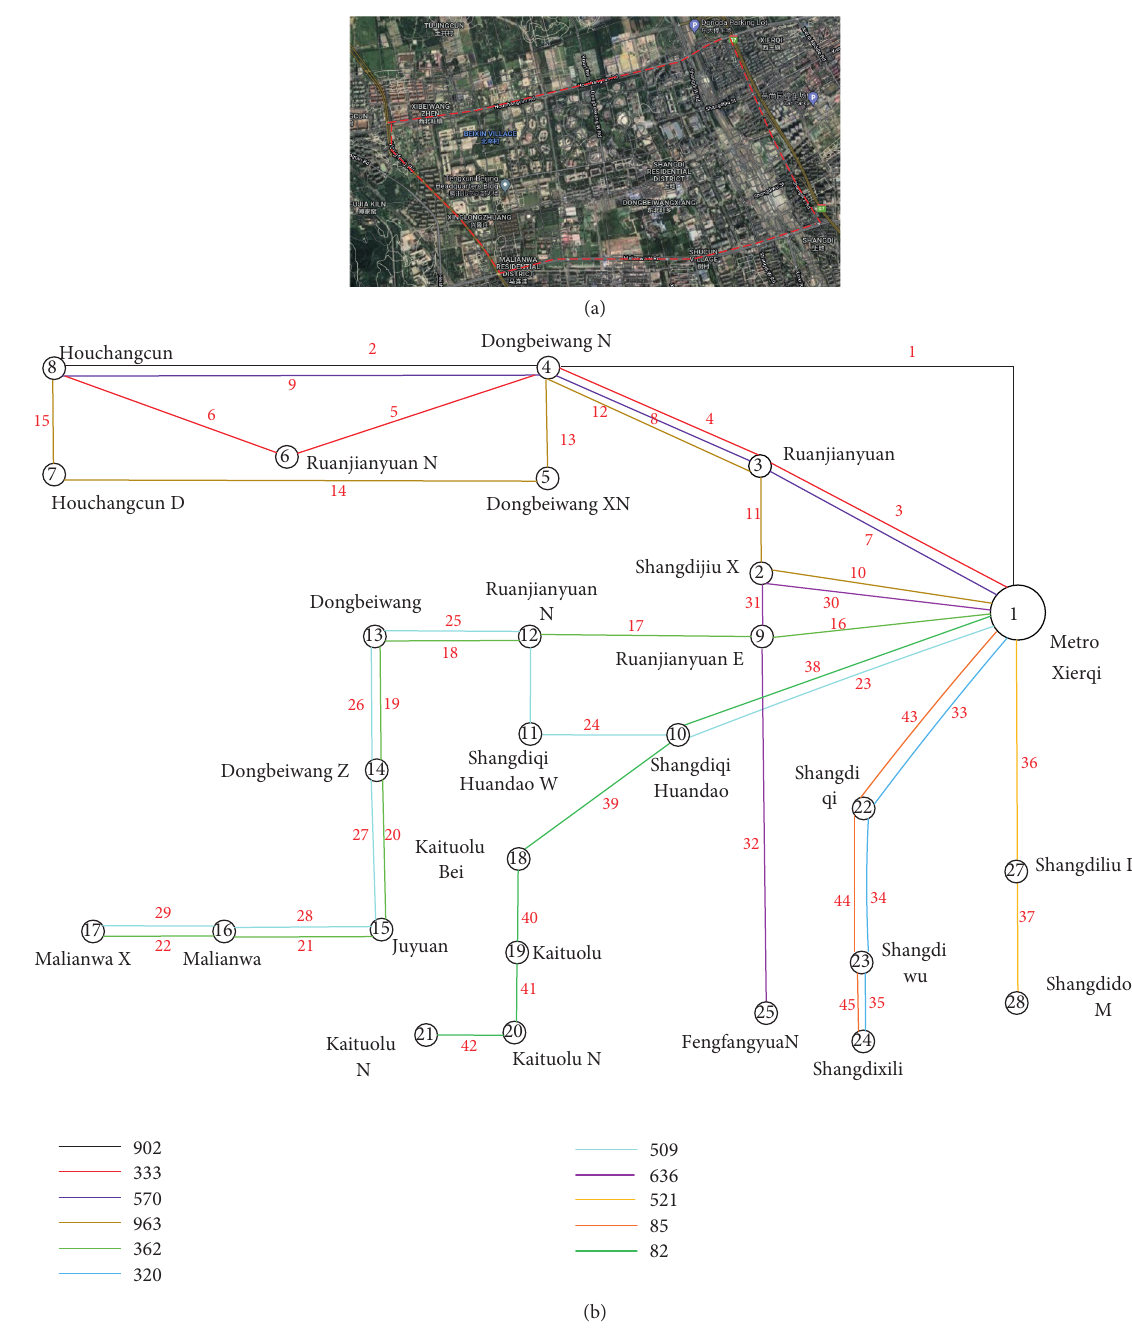
Figure 6: (a) Road network of the study area. (b) Conventional bus Table 2: Distance between bus stops.